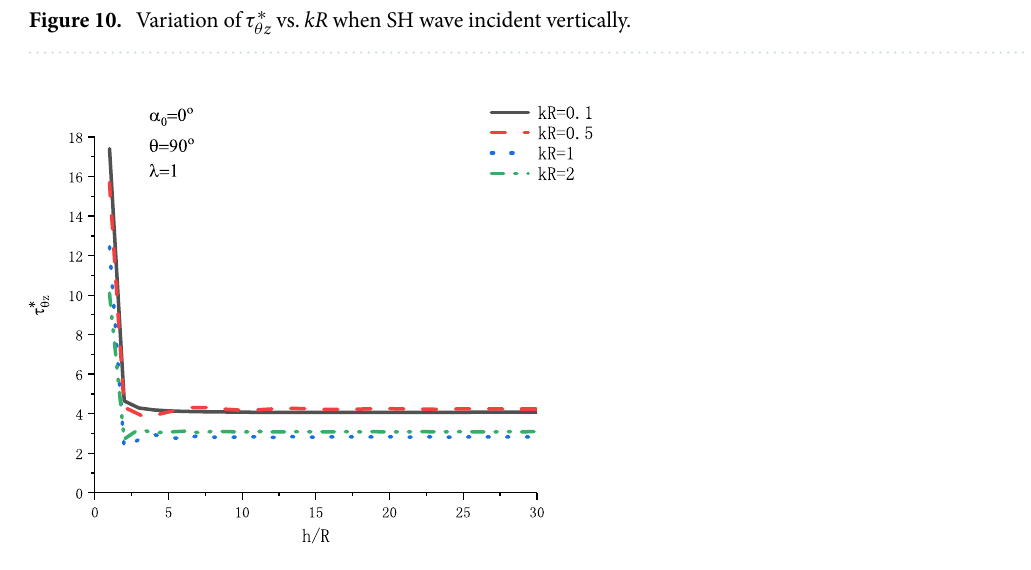
R when SH wave incident (cid:31)